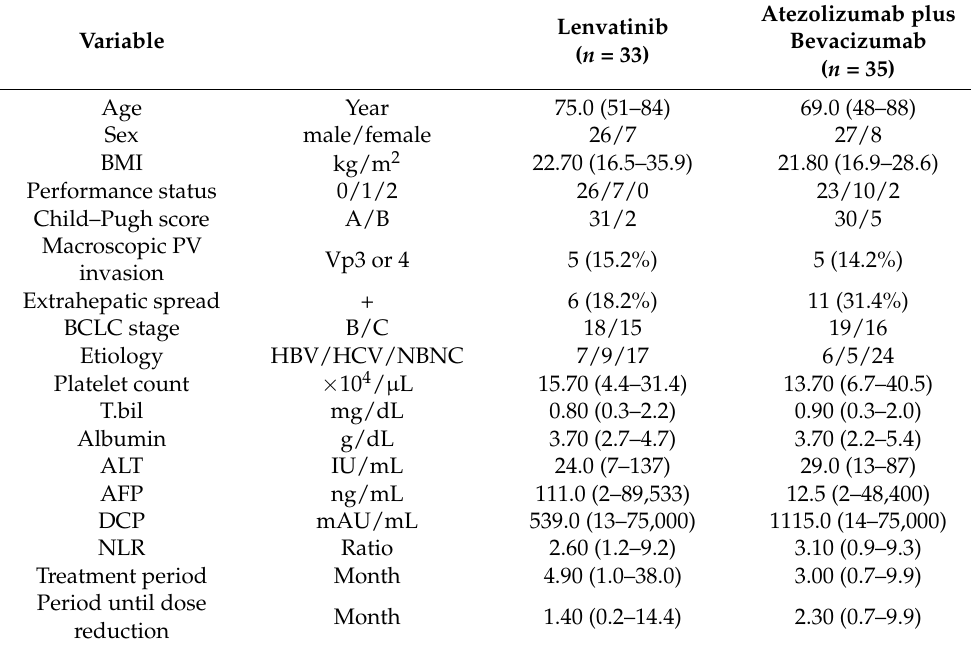
Table 1. Characteristics of the patients enrolled in the present study.